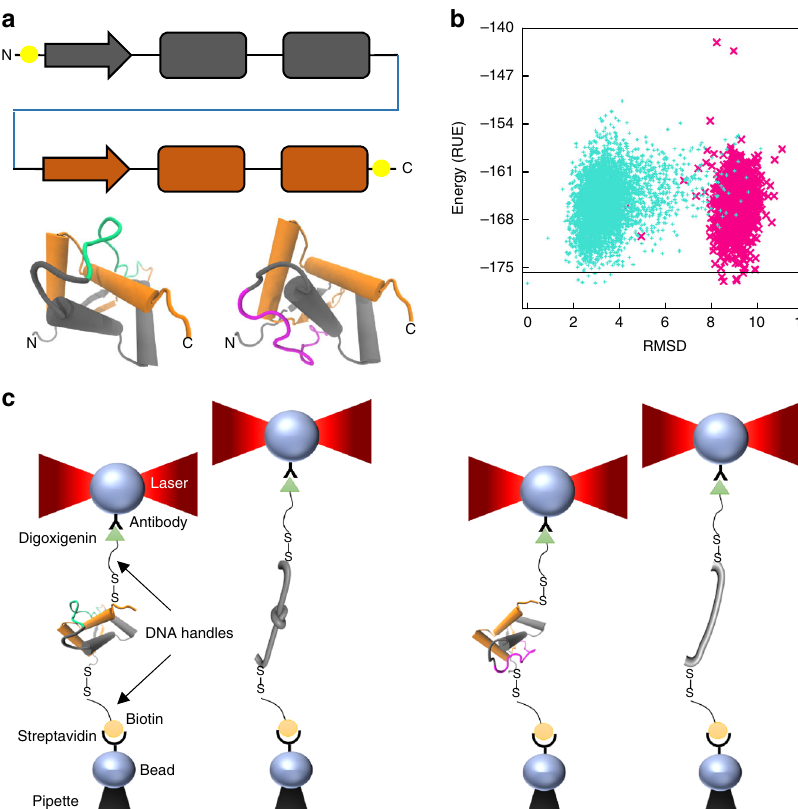
Fig. 1 Dual conformation of Arc-L1-Arc. a Upper panel, schematic representation of the single chain Arc-L1-Arc molecule. RHH motifs are depicted in orange and gray. The L1 linker is depicted in blue. For the optical tweezer experiments, cysteine residues were introduced at positions 3 and 121 (yellow dots). Lower panel, molecular models of Arc-L1-Arc show that the protein can adopt either knotted (turquoise) or unknotted (magenta) topologies depending on the conformation of the L1 linker. b Energy vs. RMSD plots for loop L1 of Arc-L1-Arc determined by Rosetta. The turquoise and magenta dots represent 6000 loop conformations forming a 3 1 -knotted or unknotted structures of Arc-L1-Arc, respectively. The black horizontal line indicates 2 Rosetta Energy Units (REU) over the lowest energy structure predicted by Rosetta and represents a threshold to highlight that the 15 most probable structures of Arc-L1-Arc are either knotted or unknotted (2 REU is about 1 kcal mol − 1 ). c Optical tweezer experimental setup. If the protein is captured with the L1 linker in turquoise conformation (left), the protein forms a tight knot upon mechanical unfolding. Alternatively, if the L1 linker is in magenta conformation (right), the protein unfolds fully extended. Models of Arc-L1-Arc are based on the structure of phage P22 ARC (PDB ID: the linker L1 in Arc-L1-Arc allows the protein to form either a knotted or an unknotted structure that are trapped and rendered non-interconvertible by placing the DNA handles.